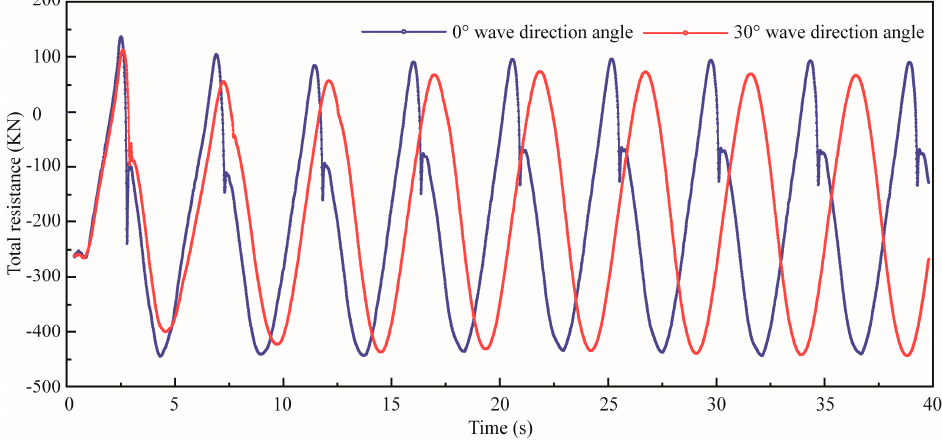
Figure 20. The total resistance in different wave directions with 7 level sea state.